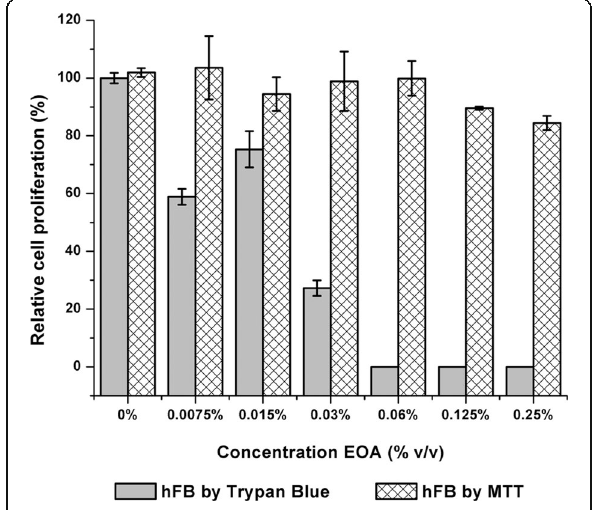
Fig. 4 Comparative of relative cell proliferation percentage of hFB cell line in the essential oil (EOA) by MTT and Trypan blue test. Error bars represent standard deviation